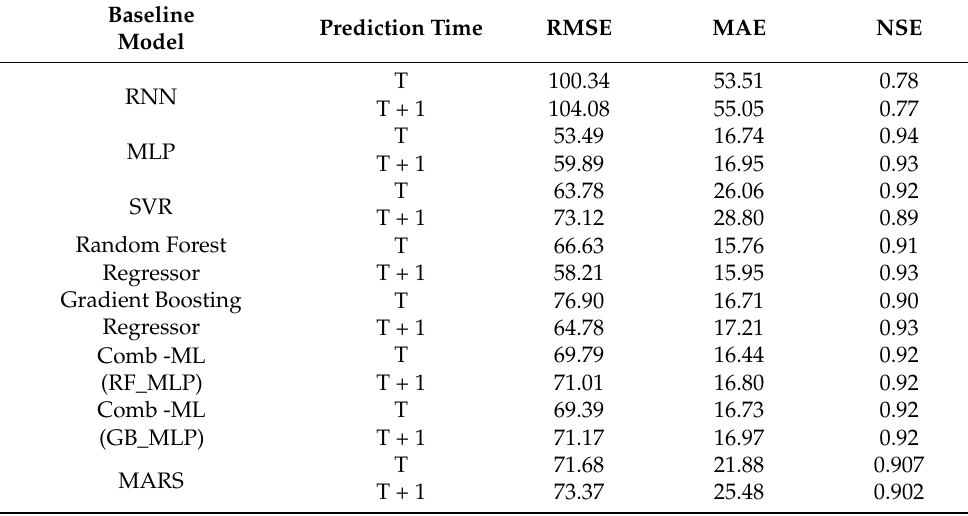
Table 8. Prediction accuracy results for baseline models.